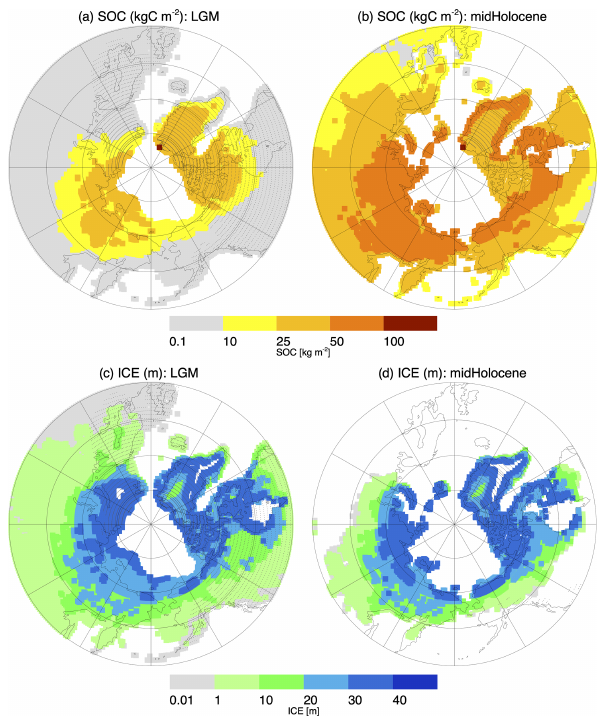
Figure 10. Snapshot maps of SOC and ICE for the periods of the Last Glacial Maximum (LGM, 22ka) and mid-Holocene (6ka). The grey dots show areas of ice sheets and glacial